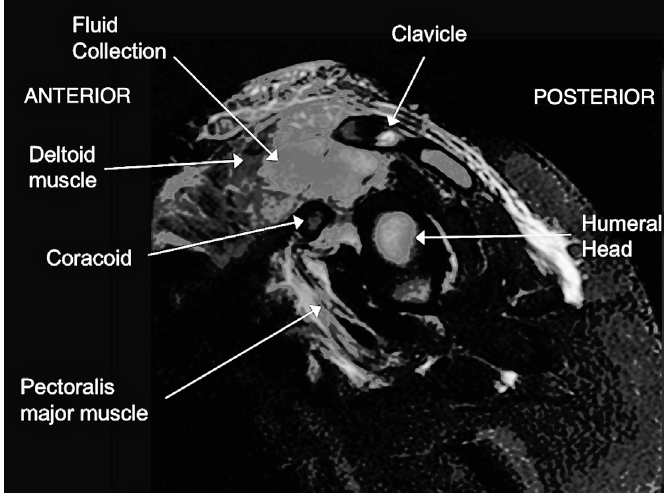
Figure. Sagittal magnetic resonance imaging of the left shoulder shows a multiloculated fluid collection within the anterior head of the deltoid and distal pectoralis major